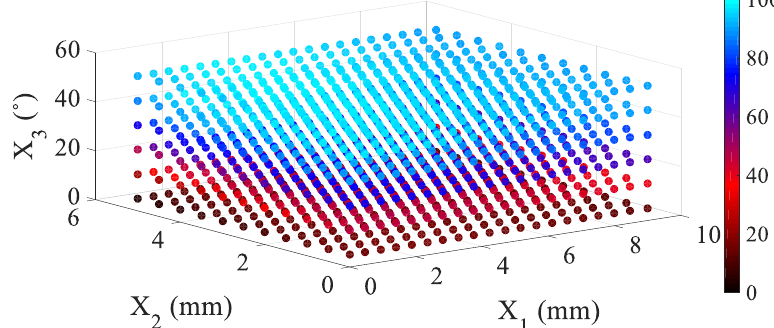
Figure 13. T avg (Nm) vs. X 1 vs. X 2 vs. X 3 .